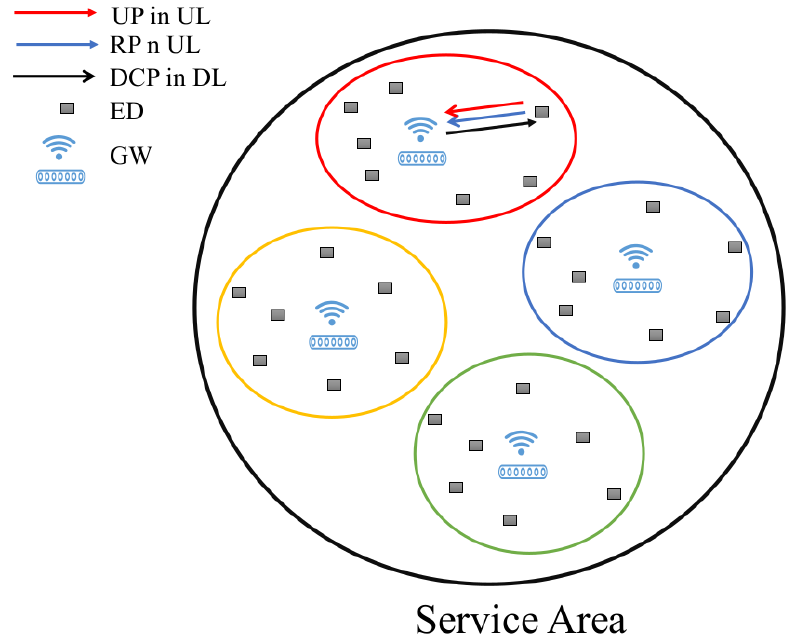
Figure 8. A service area with different clusters represented by different